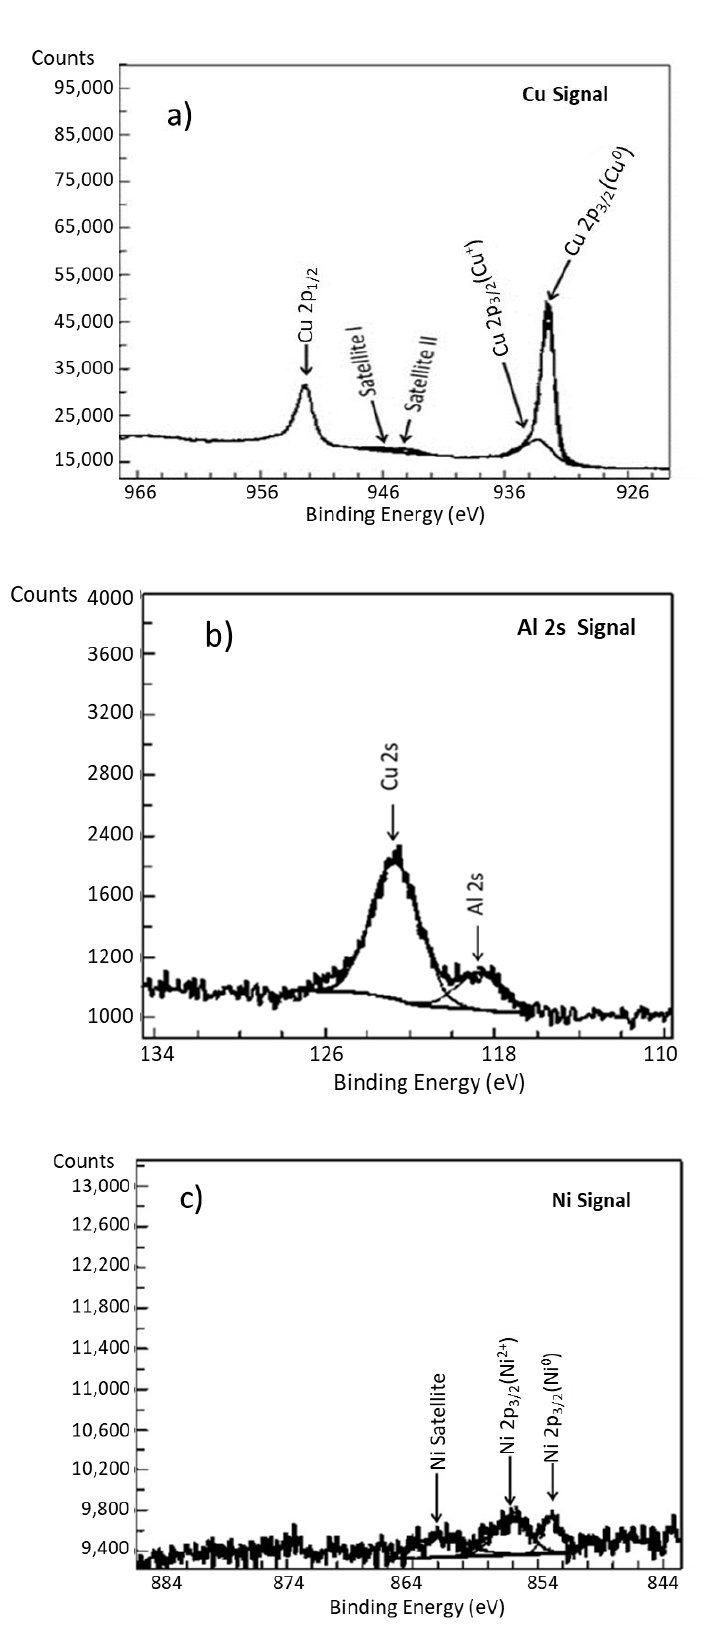
Figure 4. High-resolution XPS spectra of the native film for a B sample corresponding to the ( a ) Cu 2p and Cu 3s, ( b ) Al 2s and ( c ) Ni 2p spectra.